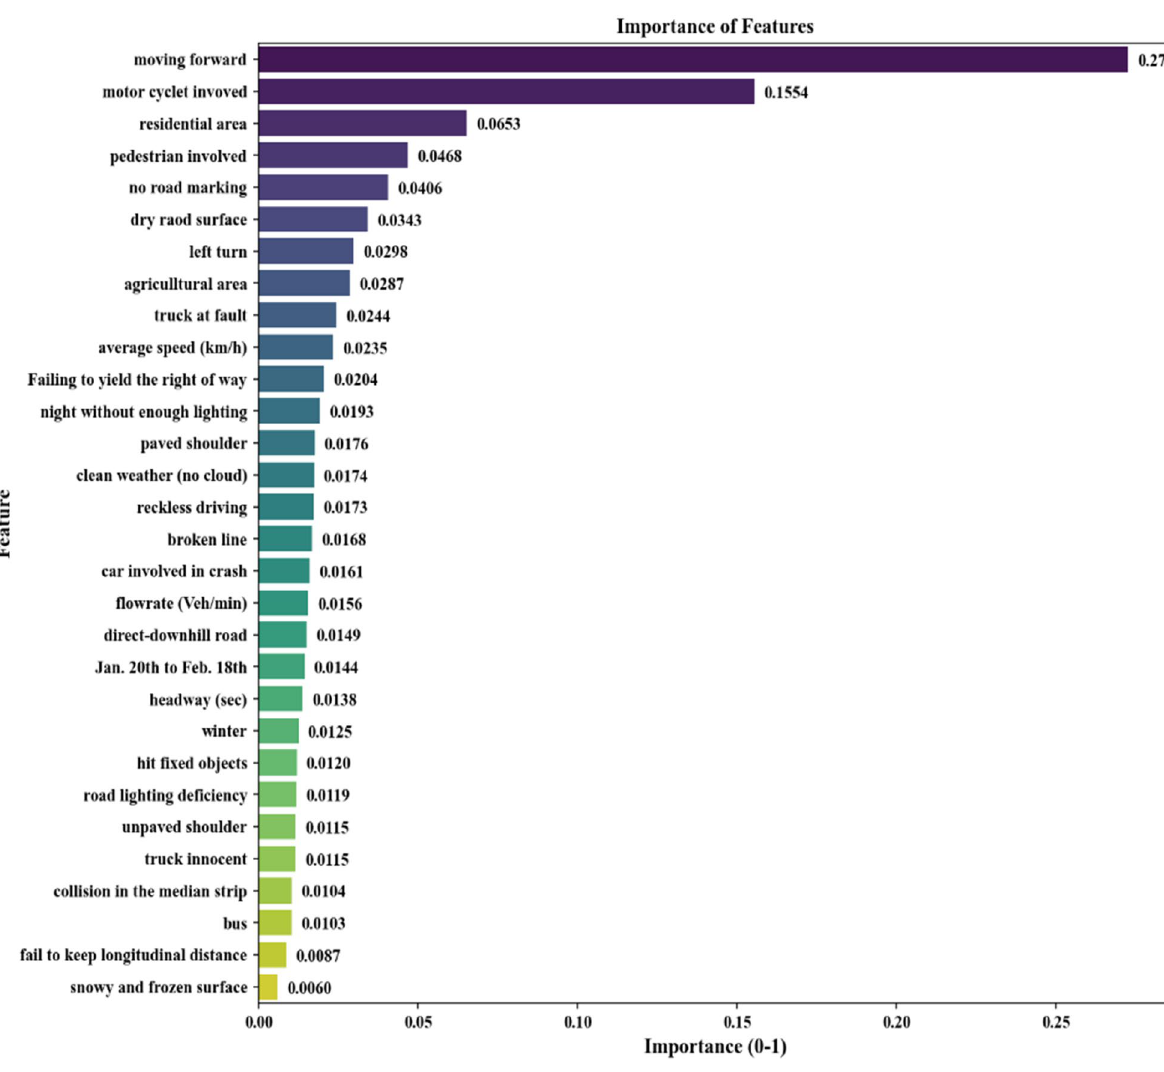
Figure 3. Importance of variables used in model [plotted by Python Matplotlib v. 3.3.4 https:// matpl otlib.